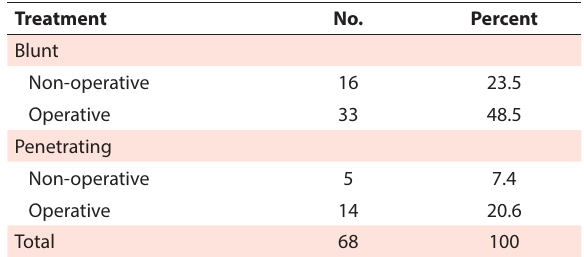
Table 4. Mode of treatment